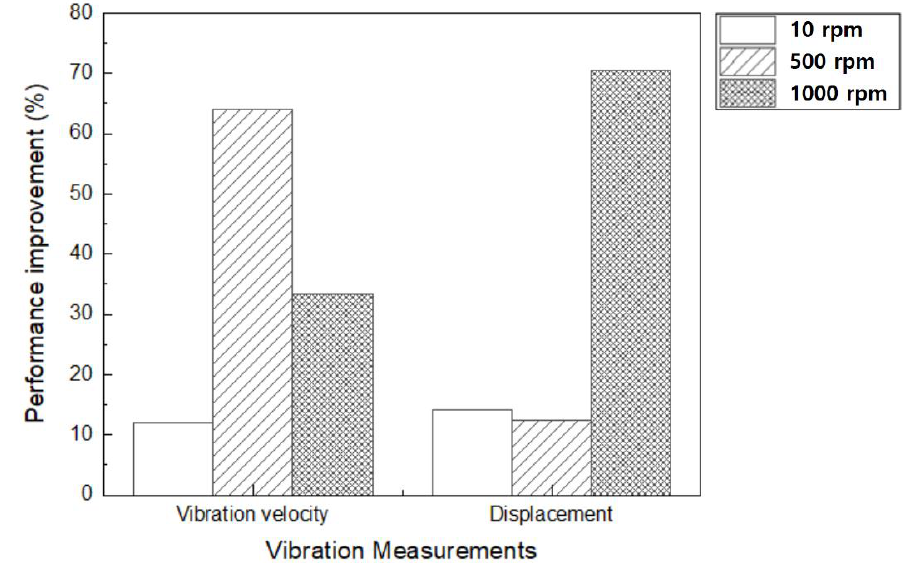
Figure 10. Performance improvement rate of the CFRP chuck adapter compared to steel in the fastening part.